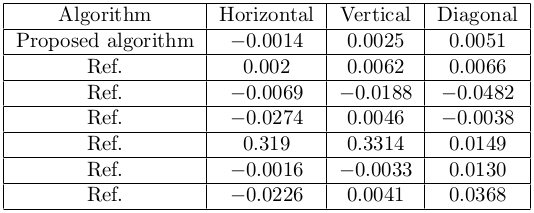
Table from the paper: An Image Encryption Algorithm Based on Chaotic Maps and Discrete Linear Chirp Transform
Table text:
Algorithm
Horizontal
Vertical
Diagonal
Proposedalgorithm
− 0.0014
0.0025
0.0051
Ref.
0.002
0.0062
0.0066
Ref.
− 0.0069
− 0.0188
− 0.0482
Ref.
− 0.0274
0.0046
− 0.0038
Ref.
0.319
0.3314
0.0149
Ref.
− 0.0016
− 0.0033
0.0130
Ref.
− 0.0226
0.0041
0.0368